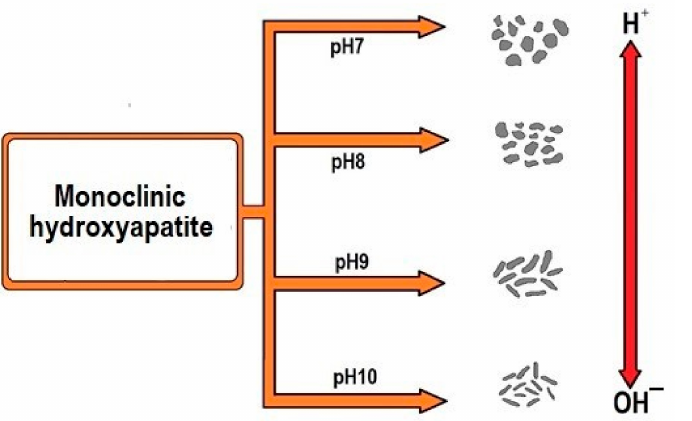
Figure 6. Schematic model for the H − and OH − ions effect representation on nanoparticles mor- phology. According to the role of OH − ions, mainly based on their orientation that may generate ferroelectric and electrical properties, this model allows showing the fundamental role of pH on the microstructural characteristics of HAp, thus contributing to better control of its size, shape and crystallographic